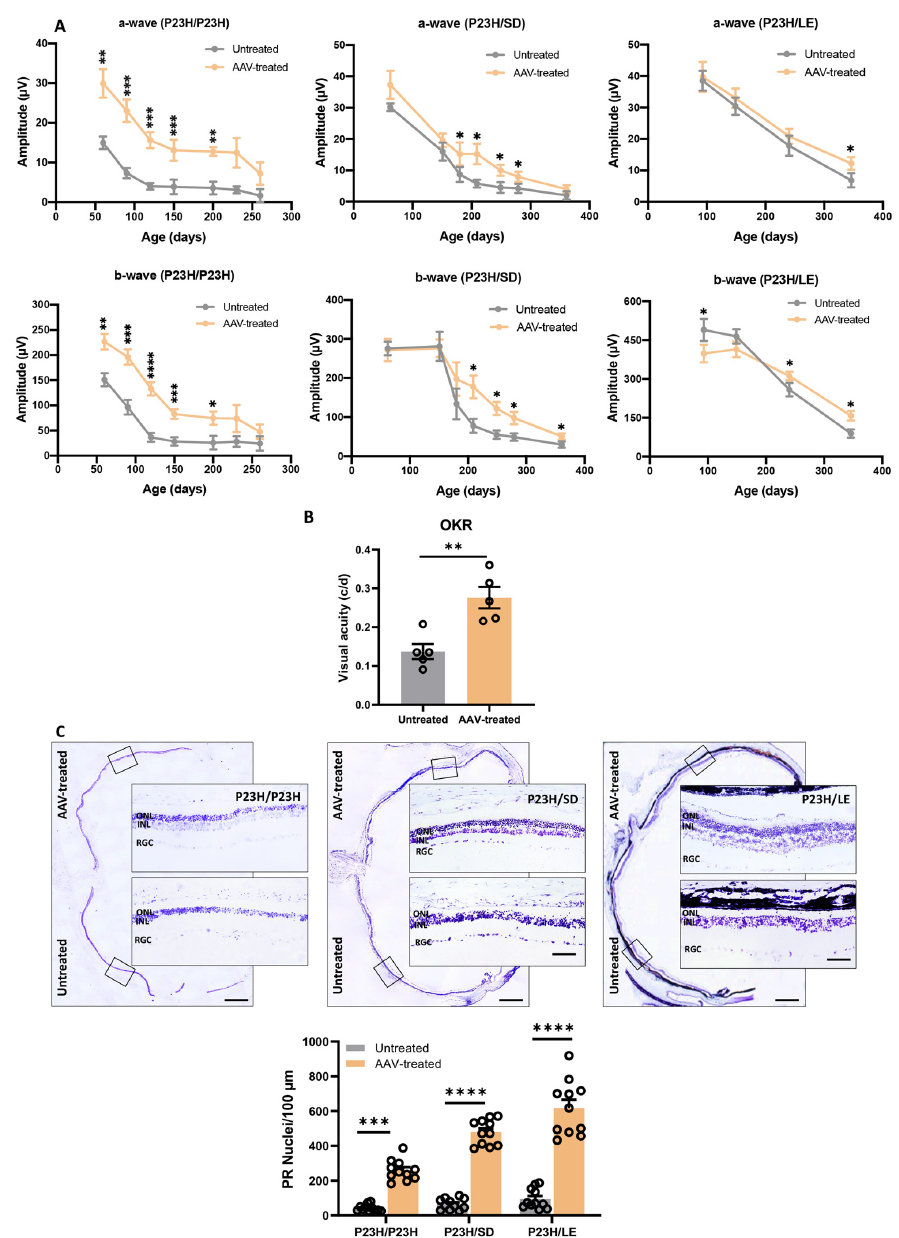
Figure 4. Visual function assessment and histological evaluation of AAV-treated P23H rats. ( A ) Functional evaluation of retinas from P23H/P23H, P23H/SD and P23H/LE rats. ERG was used to evaluate the retinal function of P23H/P23H ( n = 12) from P60-P260, P23H/SD ( n = 8) from P60-P360 and P23H/LE ( n = 12) from P90-P350. Progressive decrease in a- and b-waves was observed in AAV- treated and untreated eyes. However, AAV-treated eyes exhibited significantly higher ERG re- sponses over a longer period, suggesting that the rescued photoreceptors contributed to visual func- tion. ( B ) Optokinetic response (OKR) was tested in P23H/LE rats ( n = 5) at 15 months of age. AAV- treated eyes scored significantly higher than untreated fellow eyes. At P450, visual acuity was main- tained at over 50% of the value of wild-type rats. ( C ) Retinal montage images of cresyl violet-stained retina showing histological structure at the AAV-injection site and contralateral untreated site. The retina samples were collected from P23H/P23H, P23H/SD and P23H/LE rats, respectively at P450. Significant long-term preservation of photoreceptors is evident in AAV-treated areas compared to contralateral regions distal to the injection site that were devoid of mCherry expression. Few or no photoreceptors remained in these regions due to advanced retinal degeneration. High power images show preserved photoreceptors vs. degenerative retina distal to the injection site. At P450,